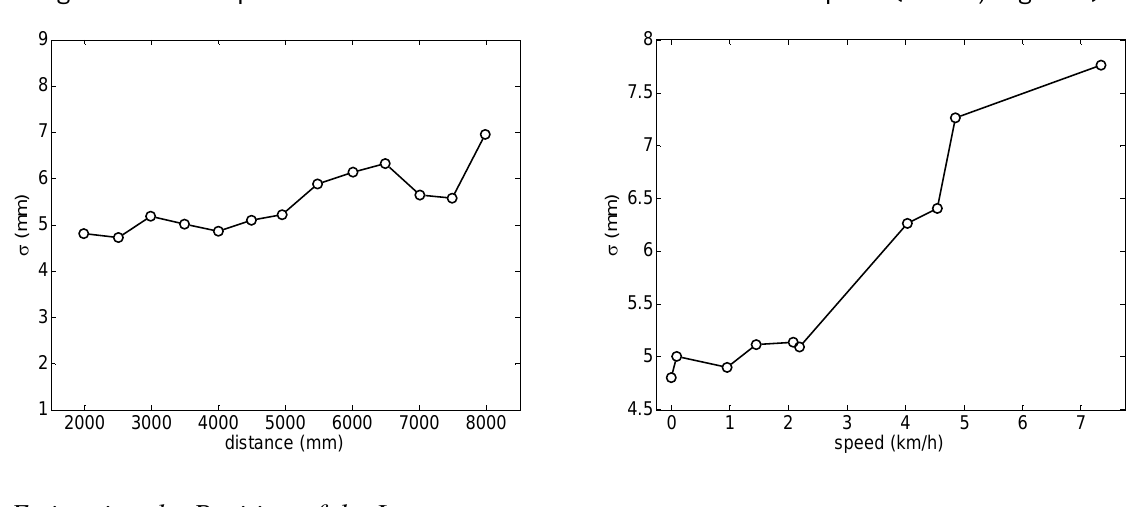
Figure 3. Left: evolution of the standard deviation relative to the distance (at angle 0°). Right: relationship between the standard deviation relative to the speed (at 5 m, angle 0°).